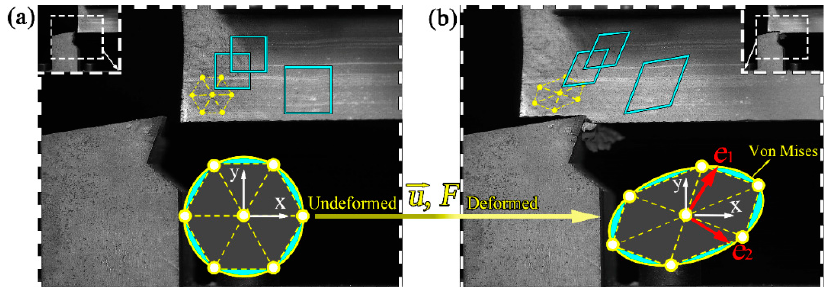
Figure 2. Graphical representation of the decomposition of deformation at cutting depth of 1.1 mm: ( a ) Before cutting edge reach SPC; ( b ) after cutting edge cut into SPC.